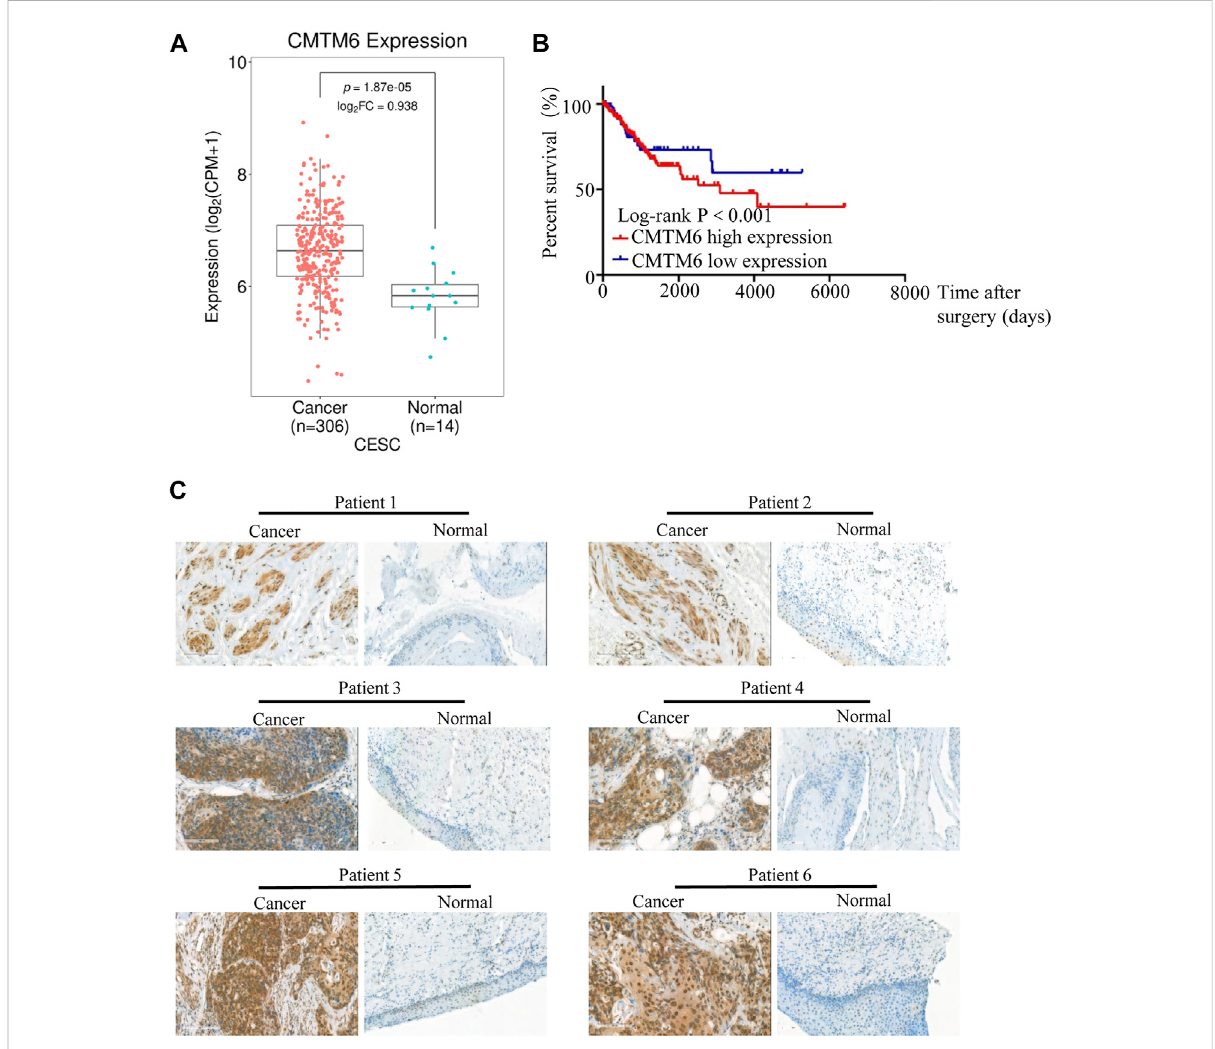
FIGURE 2 Overexpression of CMTM6 in cervical cancer tissues is indicative of poor prognosis. (A) Expressional boxplot of CMTM6 in CC based on GEPIA data; (B) patientsurvivaldatafromtheTCGAdatabase; (C) IHCdeterminationofCMTM6proteinlevelsinsixpairsofmatchedcervicalcancertissues. * p <